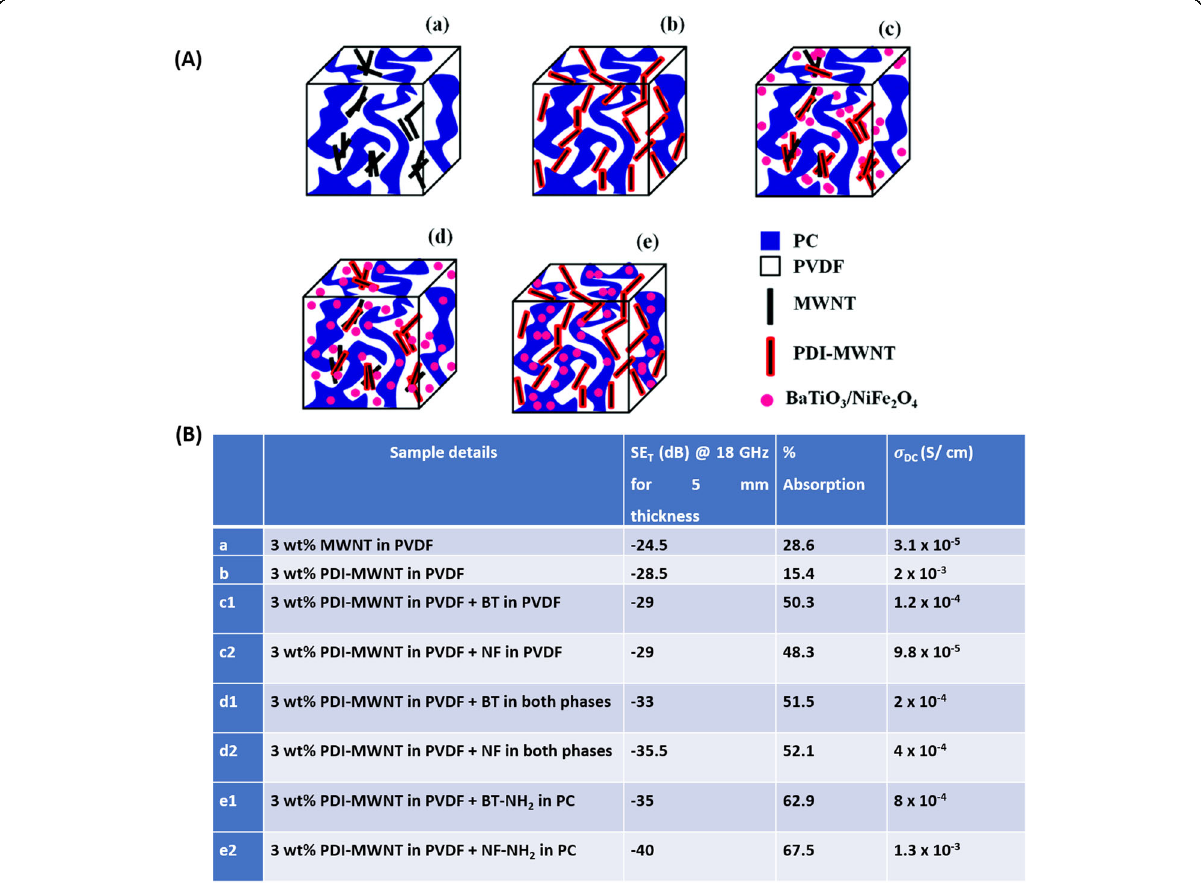
Fig. 14 (A) Schematic of the various sample configurations obtained by nanoparticle surface treatment and/or interfacial interaction; ( B ) SE T , % absorption and σ DC (obtained from dc plateau of bulk conductivity measurement) of the samples shown in the schematic representation in ( A ). Adapted with permission from Bose et al. [90], copyright 2015 Royal Society of